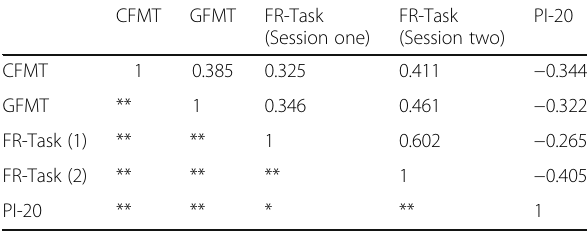
Table 1 Results of Analysis 1 showing correlation values between face identification ability measures (Spearman ’ s rho) CFMT GFMT FR-Task FR-Task (Session one) (Session two)